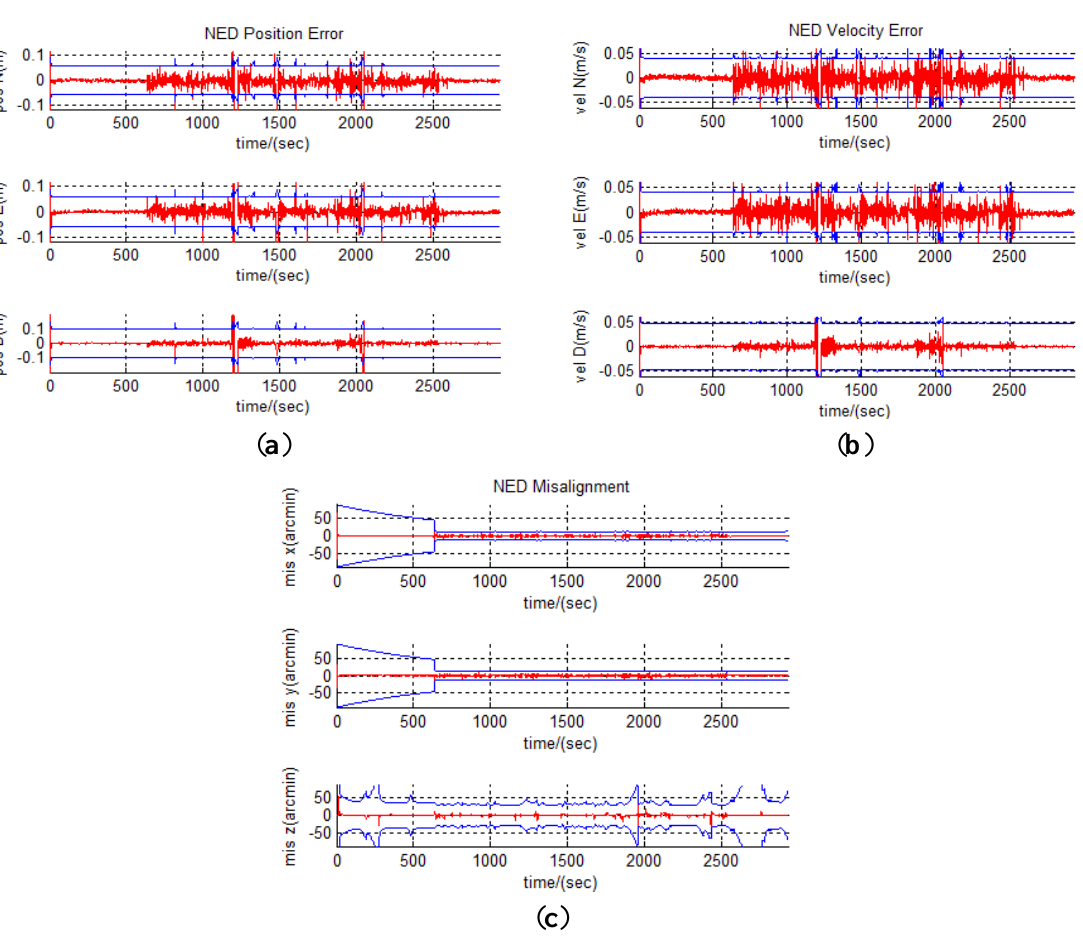
Figure 9. The estimated error states with IMU440CA (3-sigma envelope accuracy in